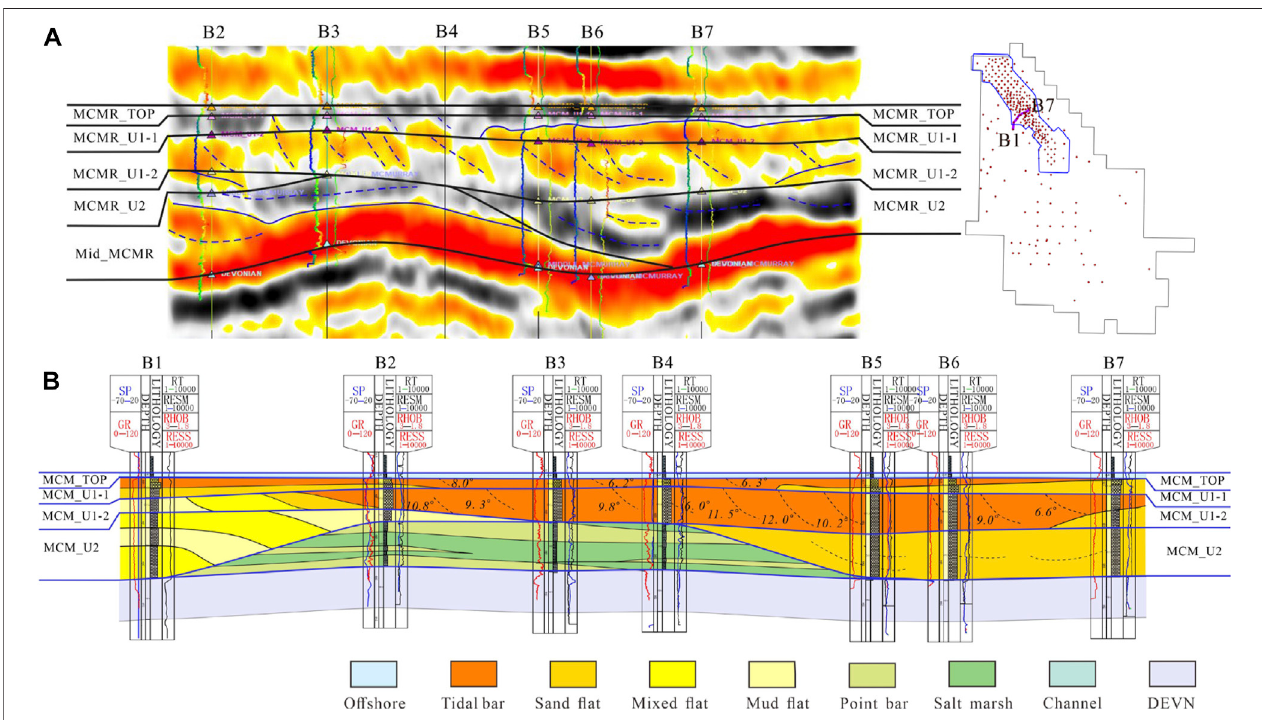
FIGURE5|(A) Theleftoneis2Dseismicpro fi leofthecross-sectionintheverticalprovenancedirection,theGrcurveontherightsideoftheloggingcurve,andthe RESScurveontheleftside.Therightoneisthelocationofthepro fi le. (B) Architectureelementanalysisoftheconnectedwellpro fi leinthedirectionofcuttingprovenance